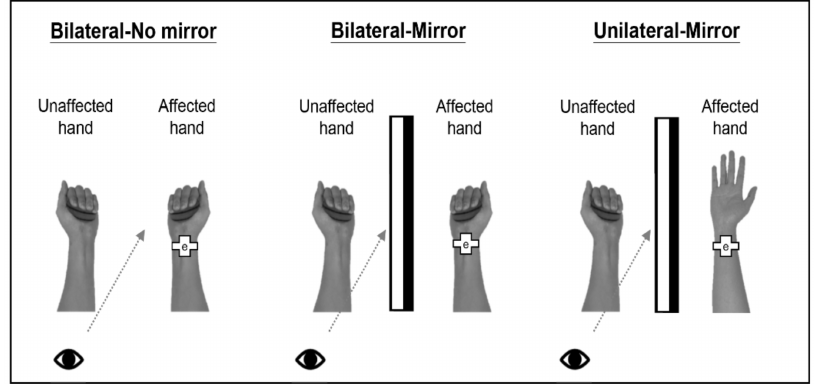
Figure 1. Schematic diagram of 3 experimental conditions. In the Bilateral-No mirror condition, the patients directly observed the affected hand’s movement while performing bilateral hand movements without a mirror. In the Bilateral-Mirror condition, the patients watched the mirror reflection of the unaffected hand’s movement while performing bilateral hand movements. Last, the patients performed the task with only the unaffected hand and observed the mirror image of the unaffected hand’s movement in the Unilateral-Mirror condition. Note: “e” in the pictures indicates the electrode of the electrical